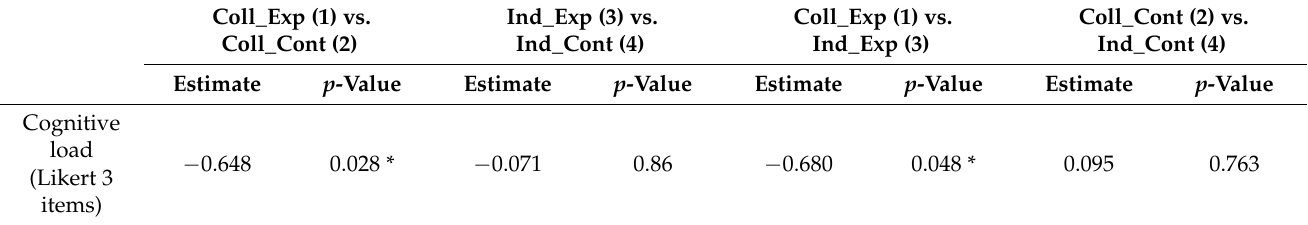
Table 4. Impact of immersion and collectivity on cognitive